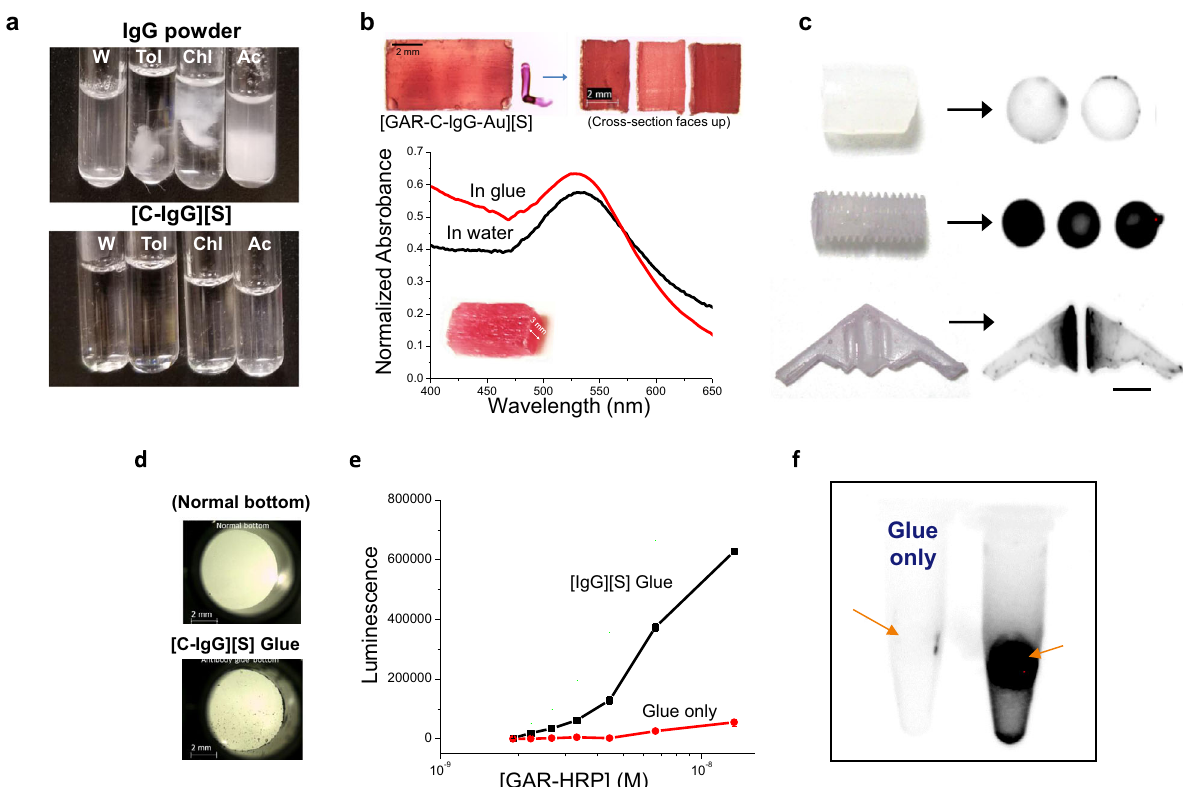
Fig. 3 Creation of bioplastic containing IgG liquids in hot glue. a Solubility of IgG powder (control) or [C-IgG][S] in water (W), toluene (Tol), Chloroform (Chl), and acetone (Ac). b Top view image of hot glue blended with [GAR-C-IgG-Au][S], molded into a single rectangular block, and then cross-sectioned into three pieces (illuminated from below on a glass slide with AFRL written). The three red block pieces are shown with cross-sectioned area facing upward and bottom illumination. UV-Vis plot of [GAR-C-IgG-Au][S] in glue or GAR-IgG-Au in water. Inset shows block dimensions. c Colorimetric assay of hot glue cylinder (control) and molded forms of [C-IgG][S]/glue after incubation with GAR-AP and addition of colorimetric substrate (Left column). Chemiluminescence of the cross-sectioned hot glue cylinder (control) and cross-sectioned forms of [C-IgG][S]/glue after incubation with GAR-HRP and addition of chemiluminescent substrate (Right column). Scale bar equals 6 mm. d Images of well bottoms from a 96-well plate with a normal surface or with the bottom replaced with [C-IgG][S] glue. e Binding assay of antibody glued well bottoms with multiple concentrations of GAR-HRP. Chemiluminescence was measured for each well using a microplate reader. Error bars represent standard deviation from triplicate measurements. f Sandwich binding assay of [anti-ferritin C-IgG][S] in glue with apoferritin and anti-ferritin antibody conjugated to HRP. Image shows chemiluminescence of control and antibody glue with arrows indicating location of glue pieces in